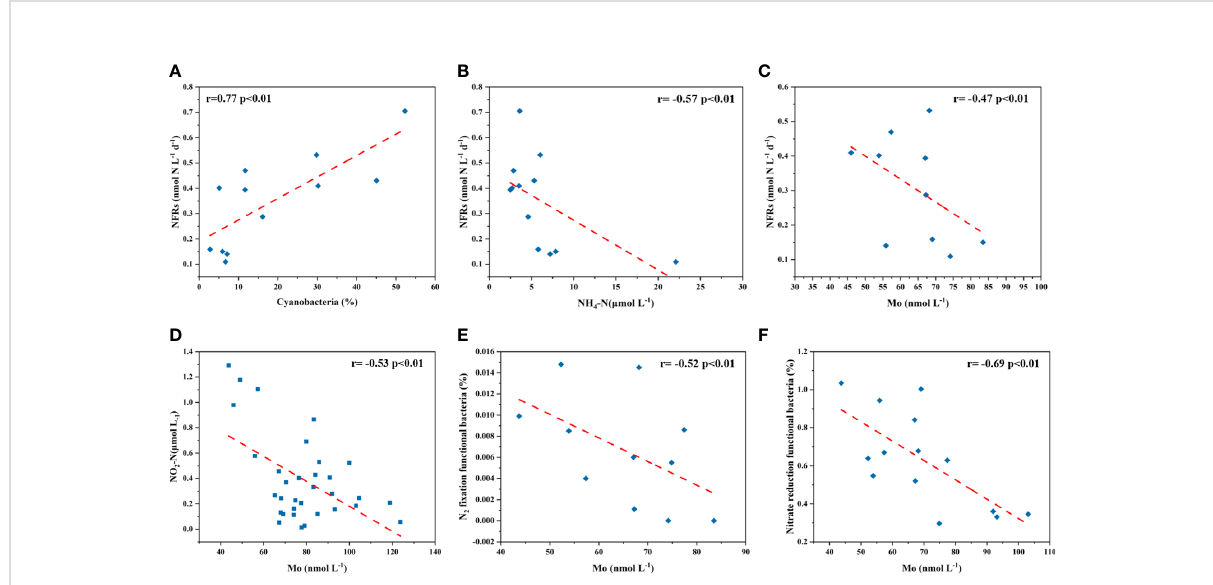
FIGURE 10 Correlations of the relative abundance of cyanobacteria with NFRs (A) , NH 4 -N with NFRs (B) in the BS and YS, dMo (<90 nmol L -1 ) with NFRs in the YS (C) , dMo with NO 2 -N (D) , dMo with N 2 fi xation functional bacteria (E) and dMo with nitrate reduction functional bacteria (F) in the BS and